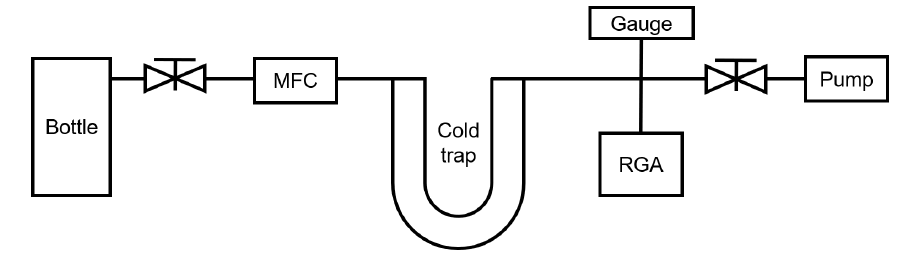
Figure 7. Layout of krypton assay